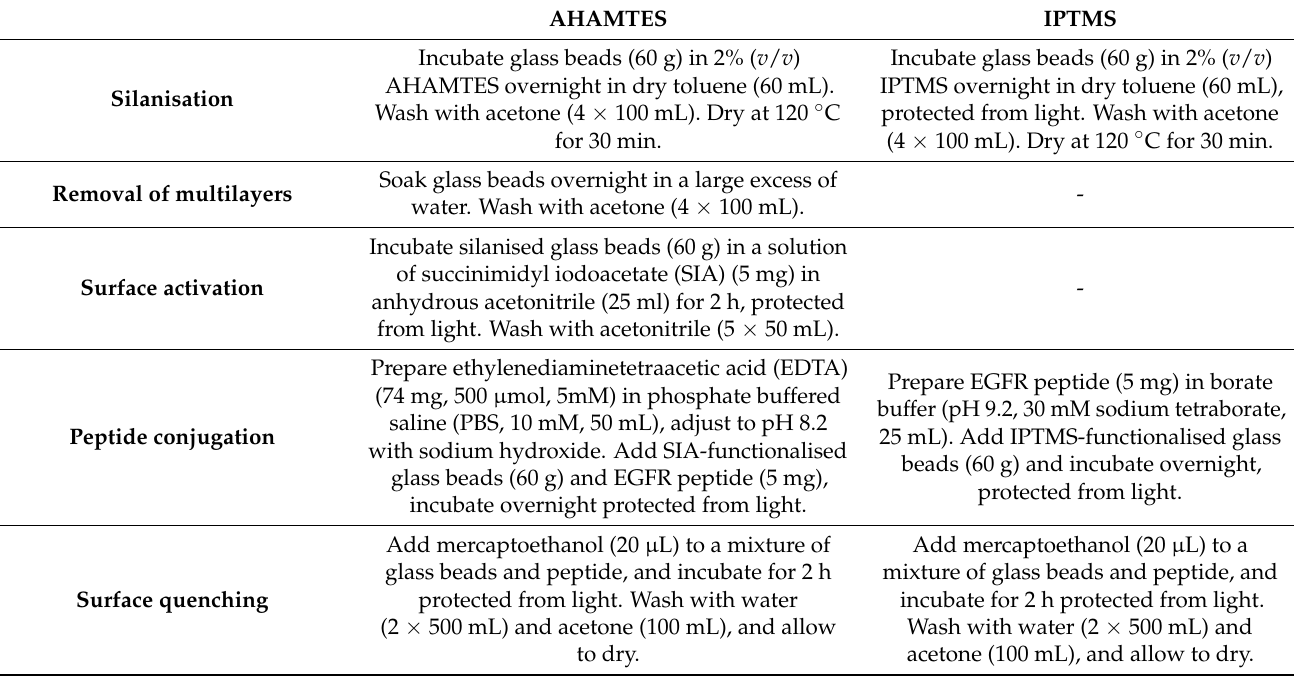
Table 1. Comparison of methodologies for AHAMTES and IPTMS-based solid phase preparation.